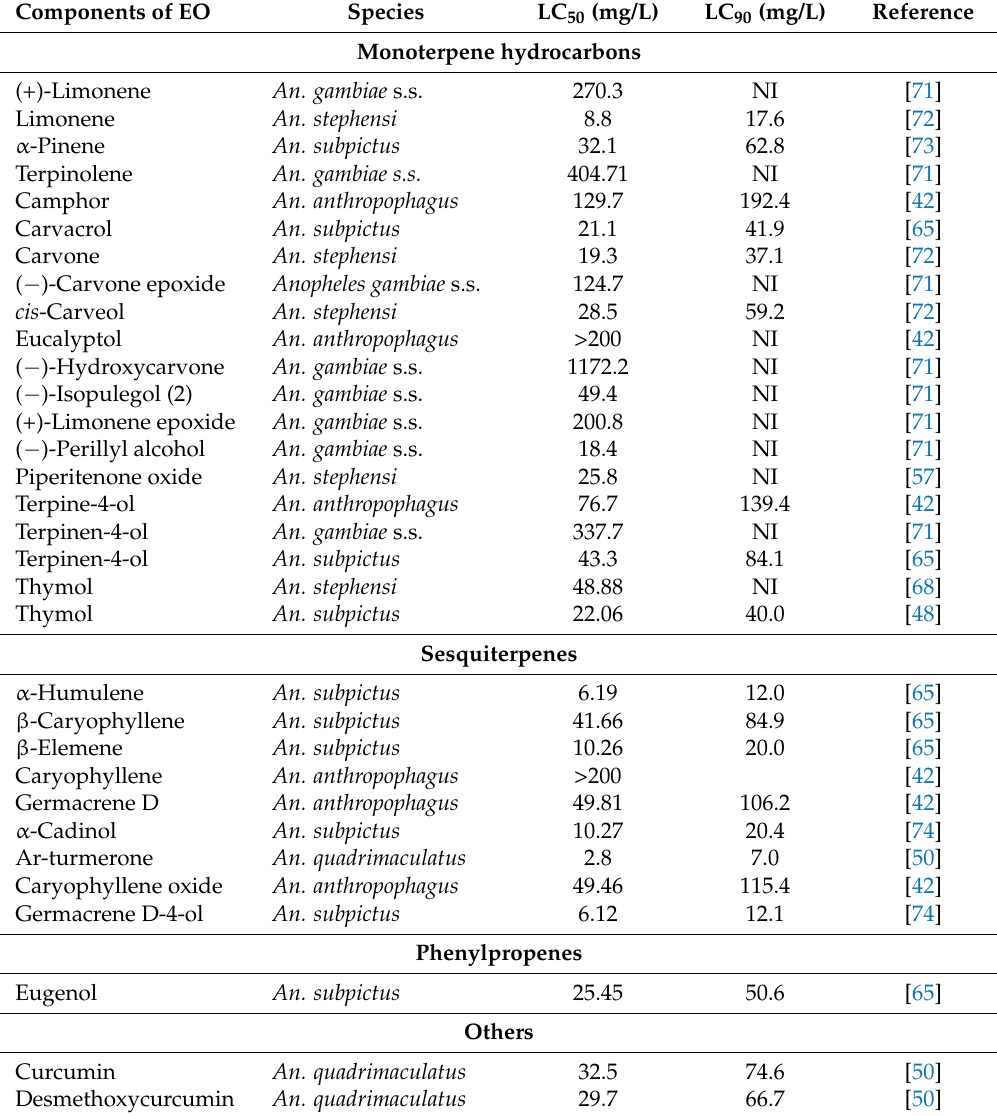
Table 3. Toxicity of essential oils components against Anopheles sp.